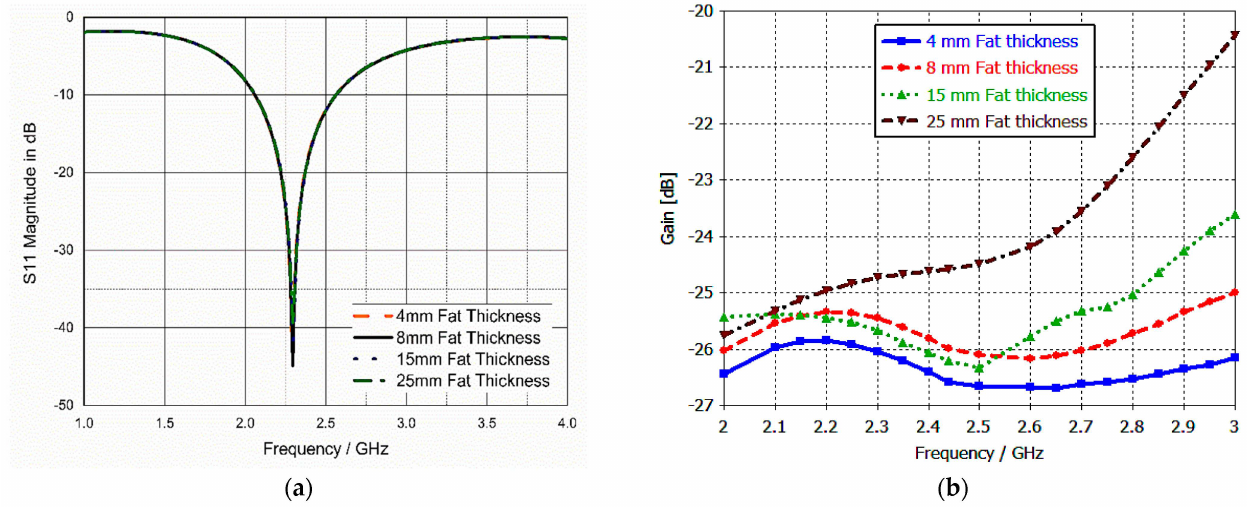
Figure 7. ( a ) S 11 parameter versus fat layer thickness; ( b ) gain (dB) versus fat layer thickness.